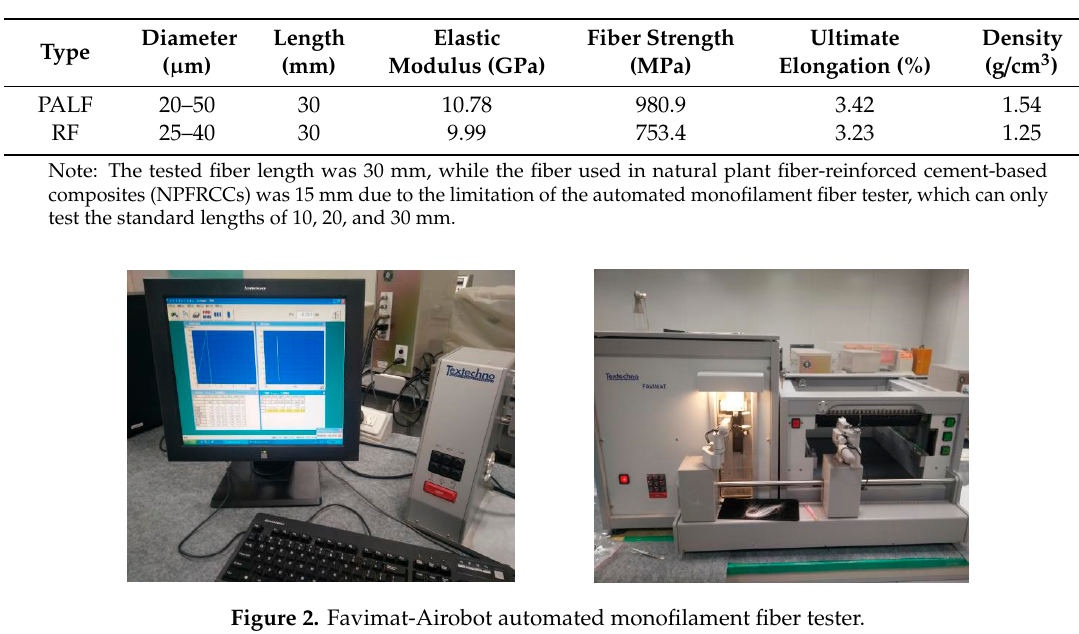
Figure 2. Favimat-Airobot automated monofilament fiber tester. Table 3. Properties of fibers.